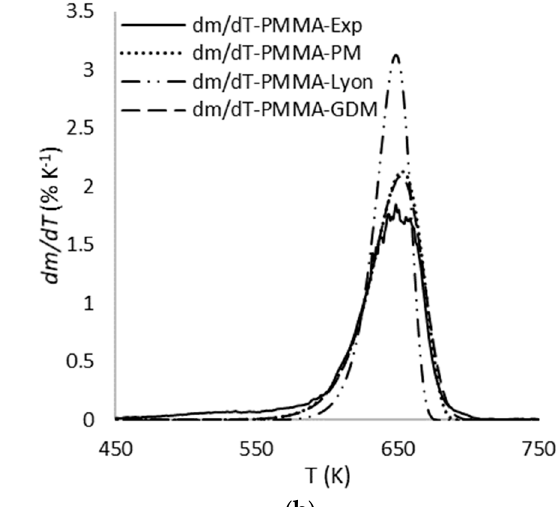
loss. Figure 13b shows that the temperature of the dm / dT maximum is accurately predicted